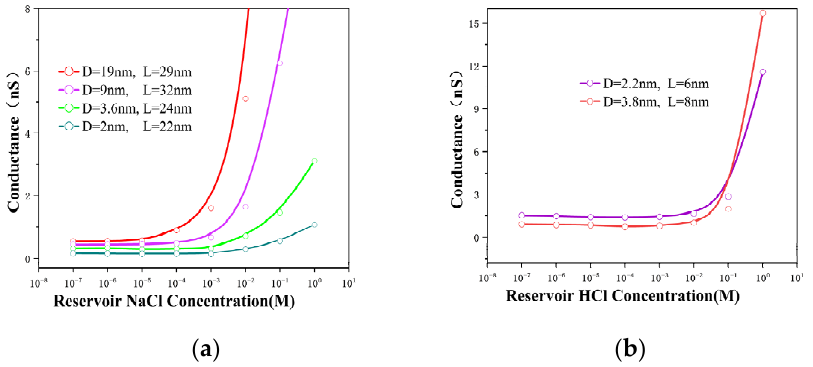
Figure 2. Conductance of HCl and NaCl at concentrations from 10 − 7 M to 1 M. ( a ) The relationship curve between the conductance measured by the nanopore experimental setup with different pore sizes and the concentration of NaCl solution. ( b ) Conductance-concentration curve of HCl.